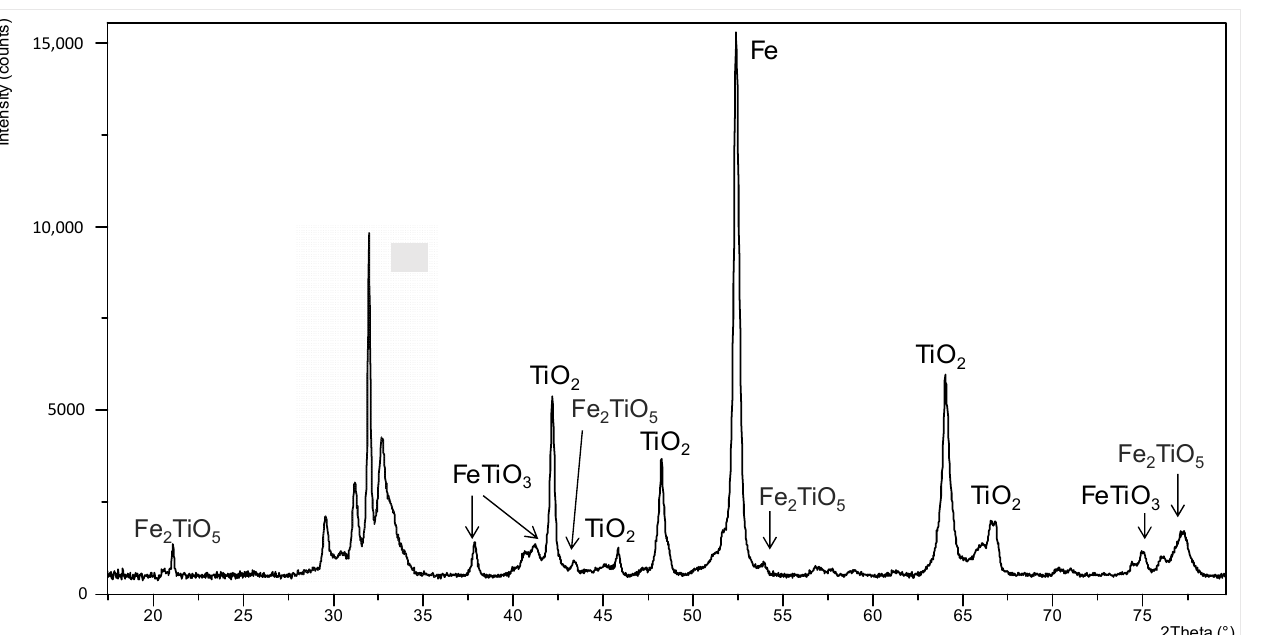
Figure 10. Average mineral abundancies of HMC and product streams of 25 weekly composite samples each.